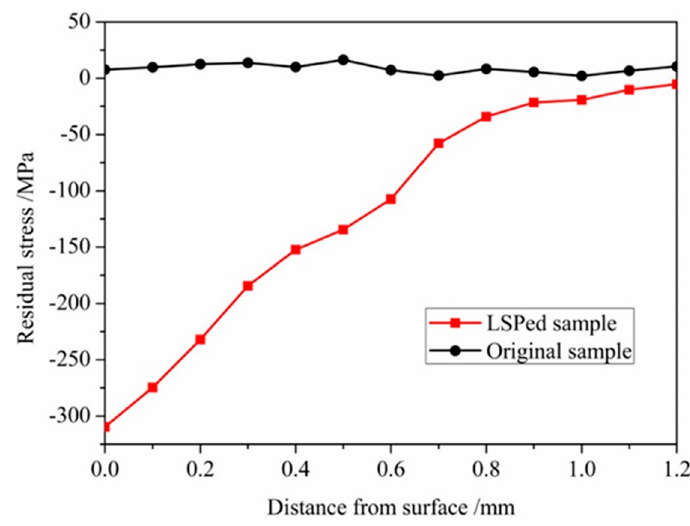
Figure 10. Residual stress distribution in depth of GH3039 sample before and after LSP treatment.